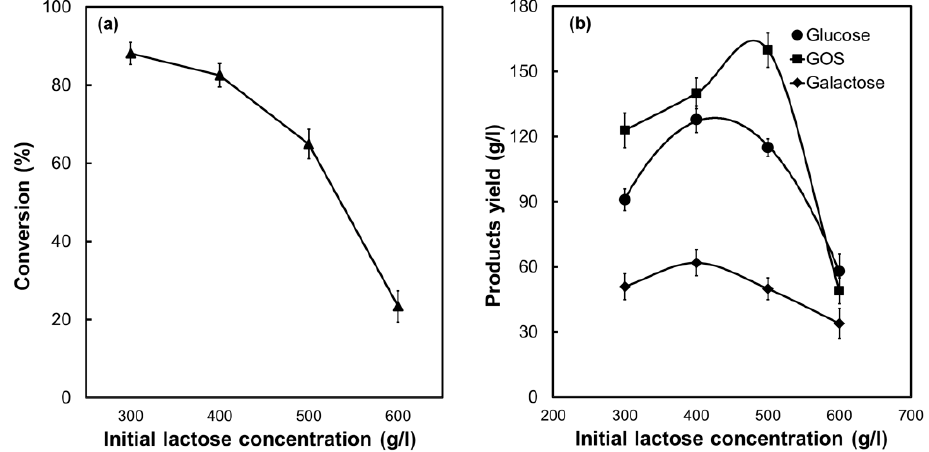
Figure 5. Profiles of ( a ) lactose conversion and ( b ) products yield of immobilized β -galactosidase on PSNF in a recirculating column reactor using lactose at various concentrations. Reactions were conducted on a lactose concentration ranging from 300 to 600 g / L at a feed flow rate of 6 mL / min, using 2 mg / mL enzyme concentration at 37 ◦ C at pH 7 for 24 h reaction. Triplicate biological samples were prepared and data are shown as mean ± SD.